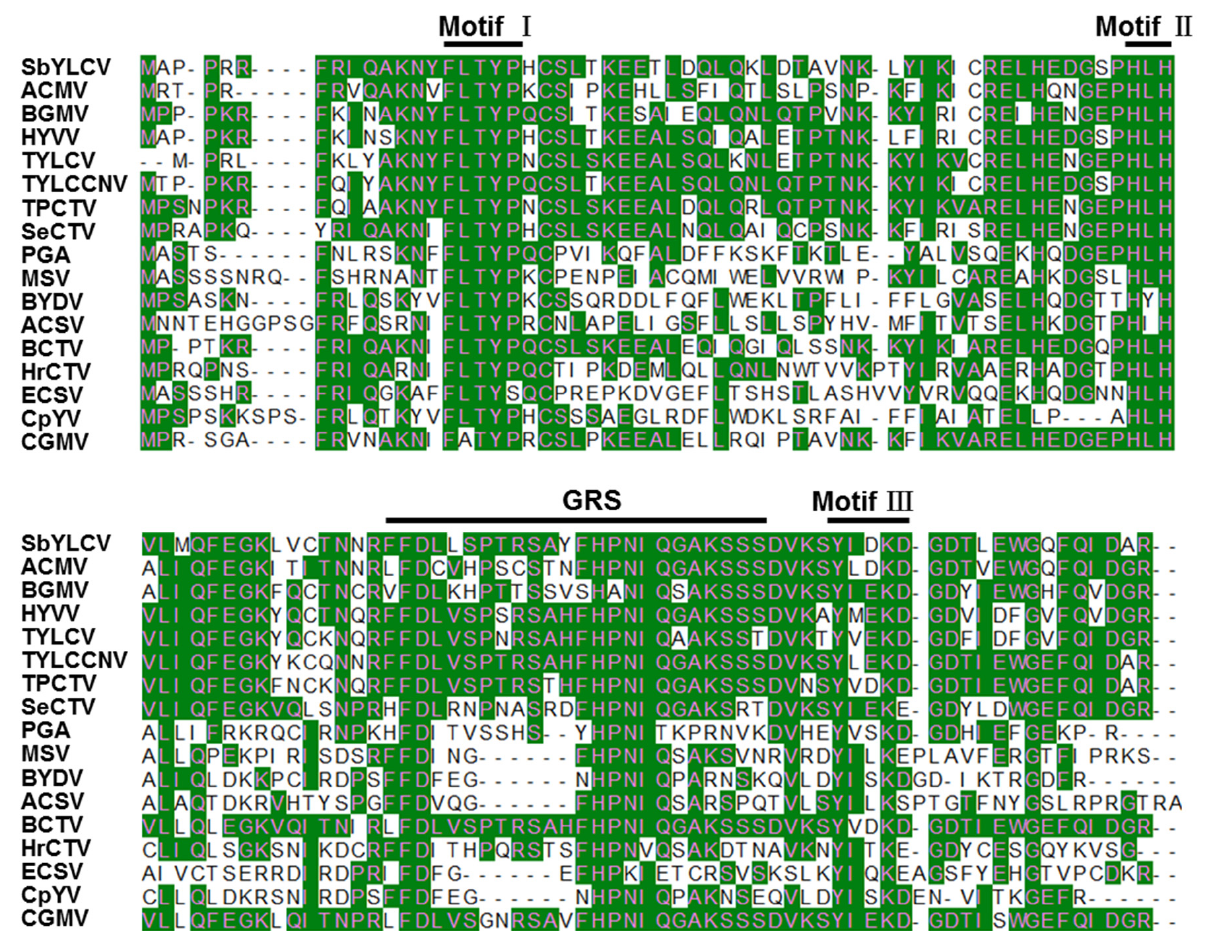
Figure 2. Alignment of the N-terminal sequences of the predicted SbYLCV Rep protein with those of selected geminiviruses. The conserved motifs I, II, III, and GRS are shown, as indicated. ACMV, African cassava mosaic virus; ACSV, Axonopus compressus streak virus; BCTV, beet curly top virus; BGMV, bean golden mosaic virus; BYDV, bean yellow dwarf virus; CGMV, cowpea golden mosaic virus; CpYV, chickpea yellows virus; ECSV, Eragrostis curvula streak virus; HrCTV, horseradish curly top virus; HYVV, honeysuckle yellow vein virus; MSV, maize streak virus; PGA, prunus geminivirus A; SeCTV, sesame curly top virus; TPCTV, tomato pseudo-curly top virus; TYLCCNV, tomato yellow leaf curl China virus; TYLCV, tomato yellow leaf curl virus.